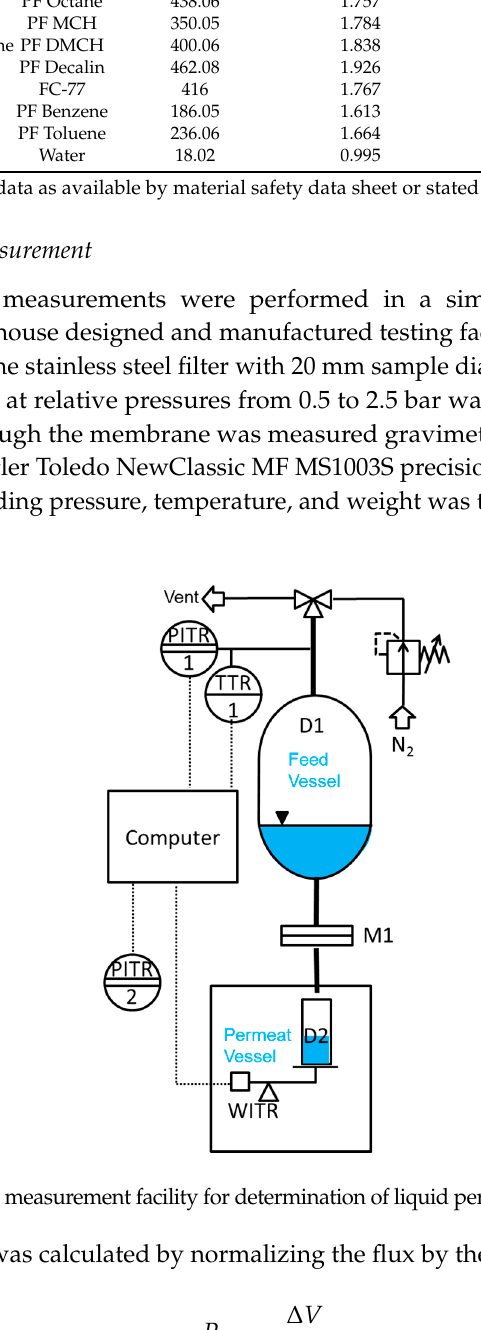
Table 2. Liquids used in this work and their physical data.